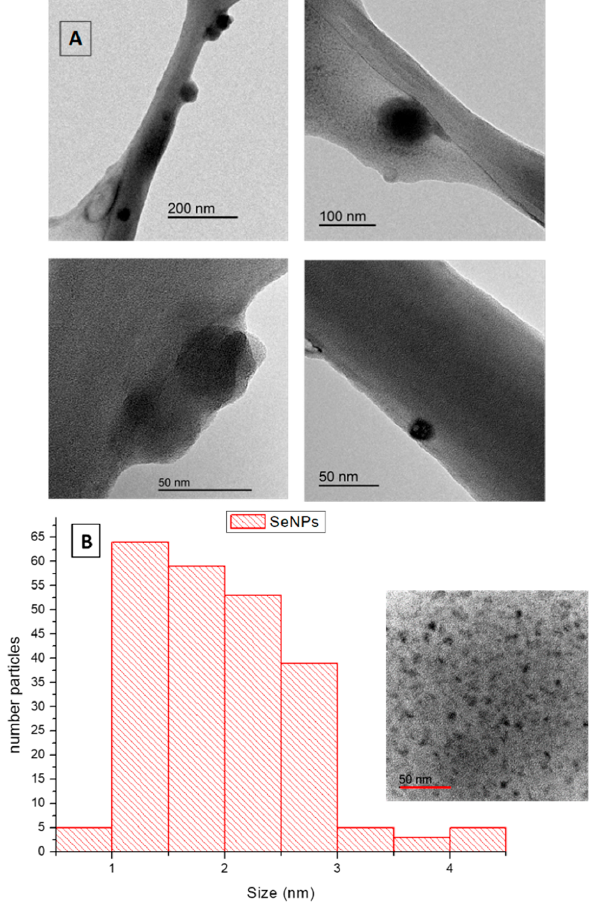
Figure 3. TEM images ( A ) and size distribution ( B ) of SeNPs obtained under optimal conditions.